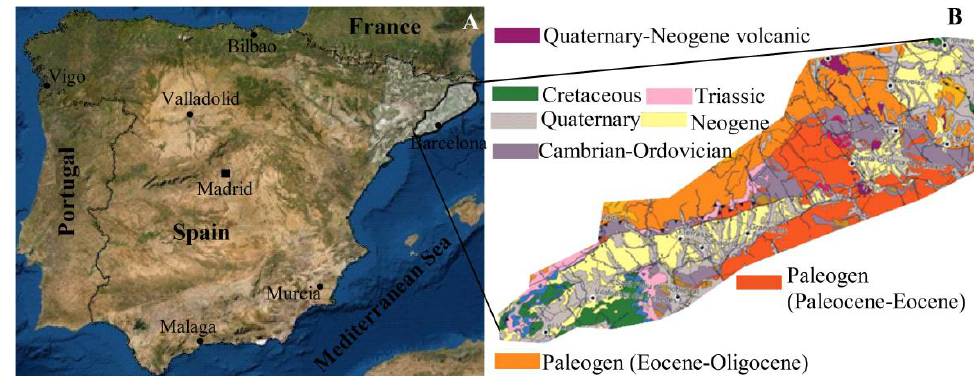
Figure 1. The location of study area in Spain ( A ) and the corresponding geological settings ( B ).